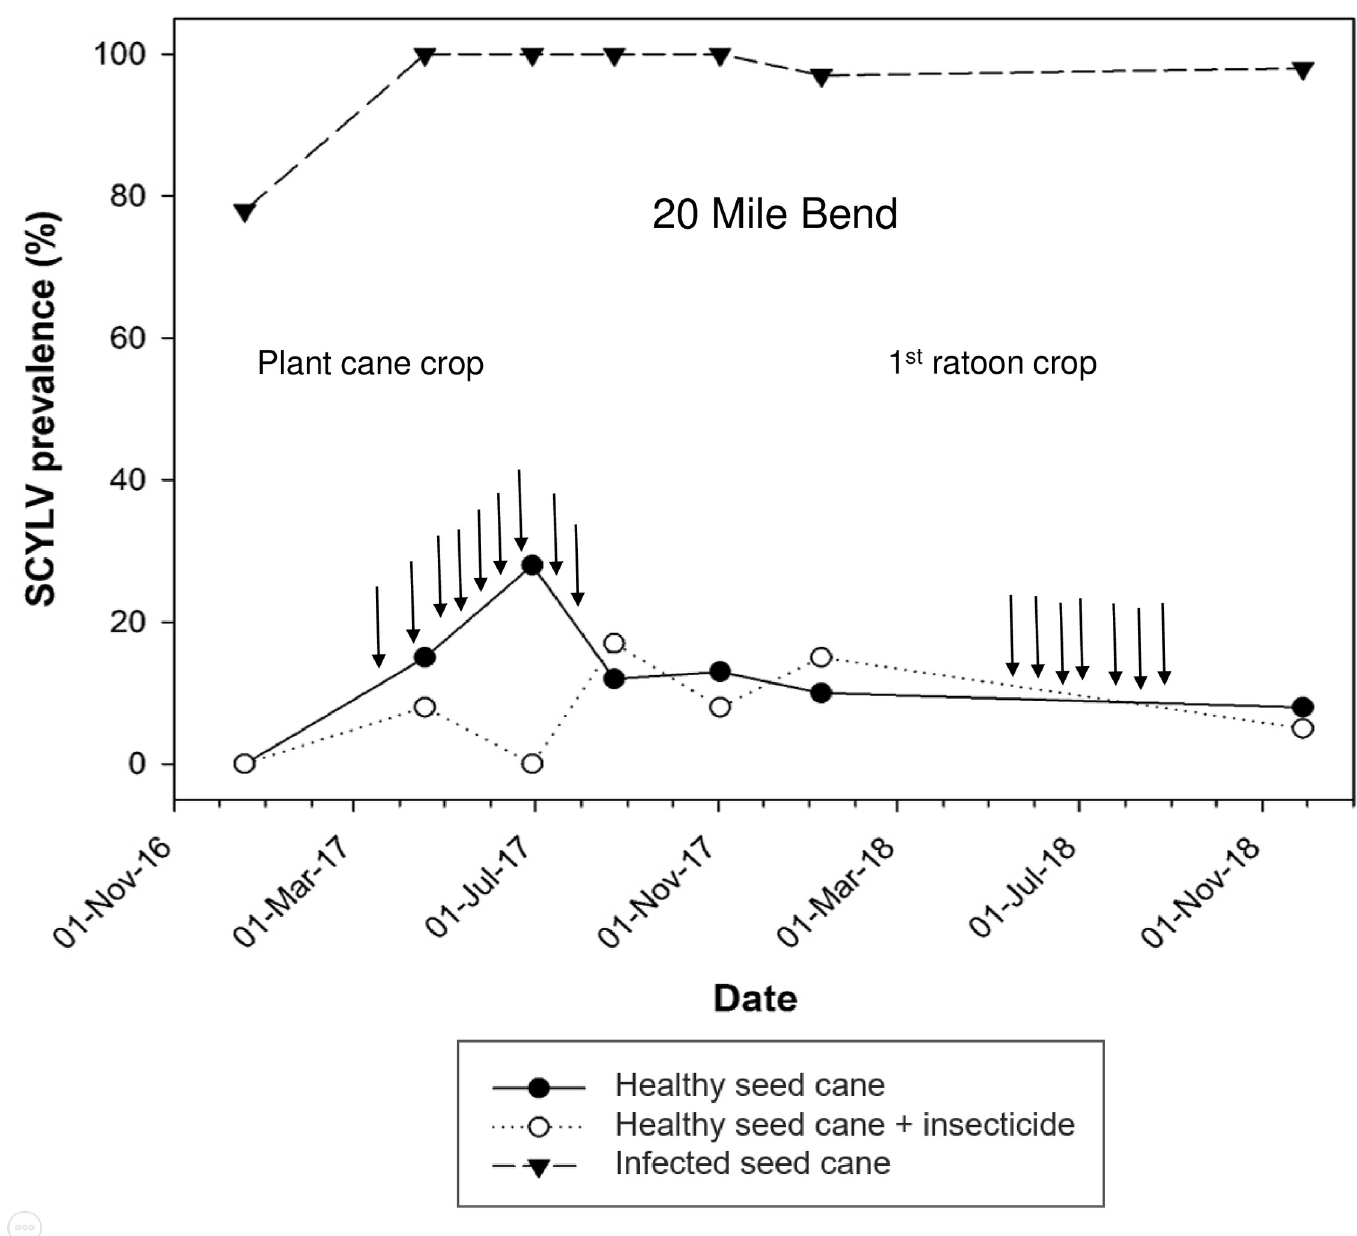
Fig 3. Progress of prevalence of sugarcane yellow leaf virus (SCYLV) in sugarcane cultivar CP96-1252 grown on mineral soil (at 20 Mile Bend). Sugarcane was planted on 18 December 2016 and harvested at the end of the plant cane crop on 17 March 2018. Sugarcane was harvested in the first ratoon crop on 13 February 2019. Prevalence of SCYLV was determined from December 2016 to the end of November 2018. Insecticide was applied in the plant cane crop at the following dates (vertical arrows): 21 March 2017, 19 April 2017, 3 May 2017, 17 May 2017, 31 May 2017, 14 June 2017, 28 June 2017, 12 July 2017 and 26 July 2017. Insecticide applications were performed in the first ratoon crop at the following dates (vertical arrows): 22 May 2017, 4 June 2018, 20 June 2018, 7 July 2018, 31 July 2018, 17 August 2018 and 31 August 2018. Each data point represents the mean percent of infection of six plots (10 leaves/plot).